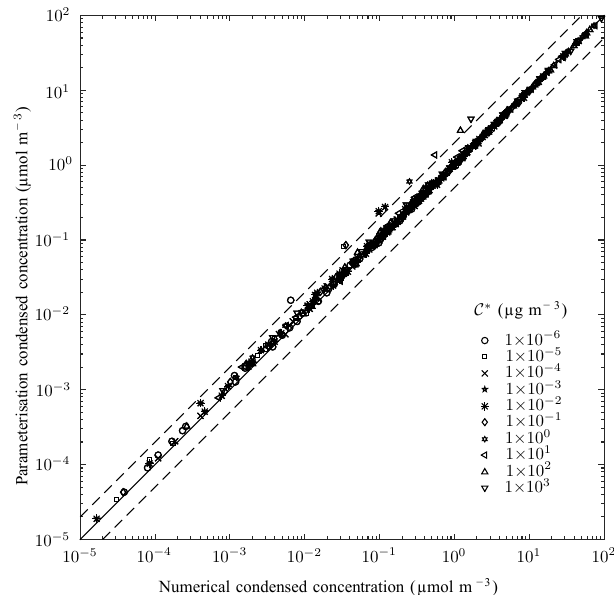
Figure 4. Comparison of the condensed concentrations of organ- ics from the leading-order solution against those calculated using the non-linear solver for randomly chosen parameters from Table 1. Concentrations of the SVOCs are chosen randomly by rescaling the volatility distribution given in Table 2 by between 0 and 100. The solution is calculated for between two and six modes, and only the condensed concentrations on the first mode are plotted. The differ- ent volatility bins are distinguished by the shape of the points and the corresponding C ∗ values given in the legend. The 1 : 1 line is shown in solid black and the dashed lines show the 1 : 2 and 2 : 1